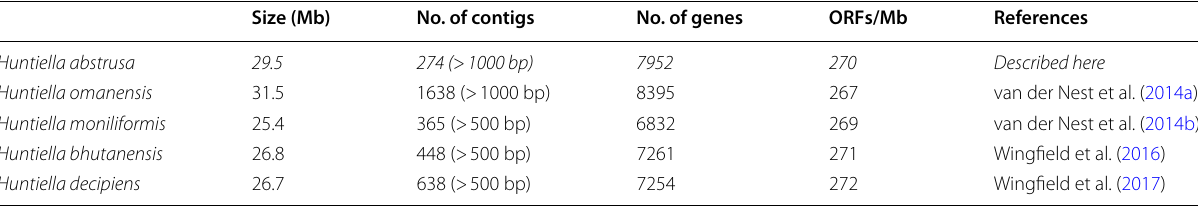
Table 1 Genome statistics of the draft genome assemblies available for various Huntiella species Size